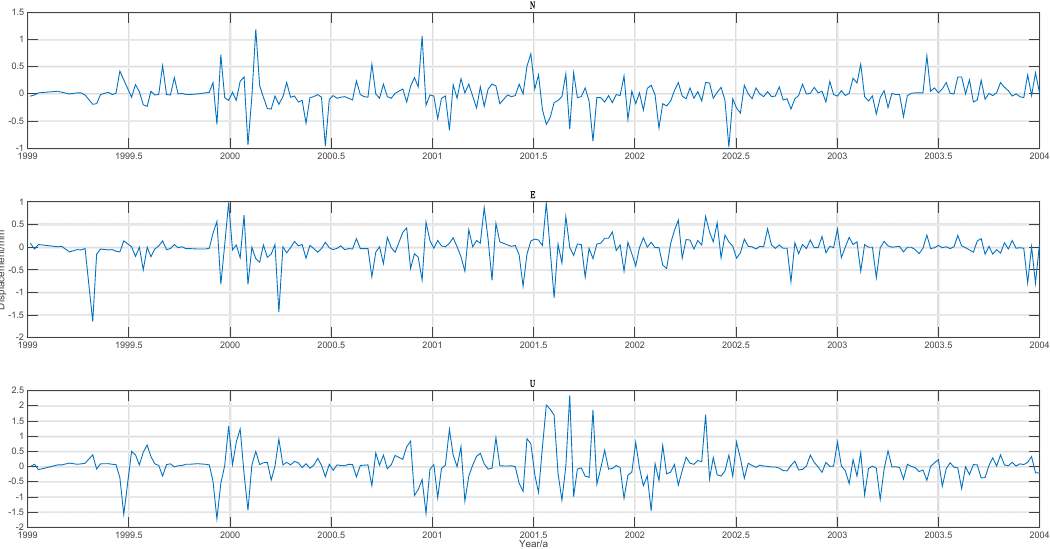
Figure 3. The GPS coordinate time series for station BRAZ ( top ) and REYK ( bottom ) due to the S1/S2 effects.